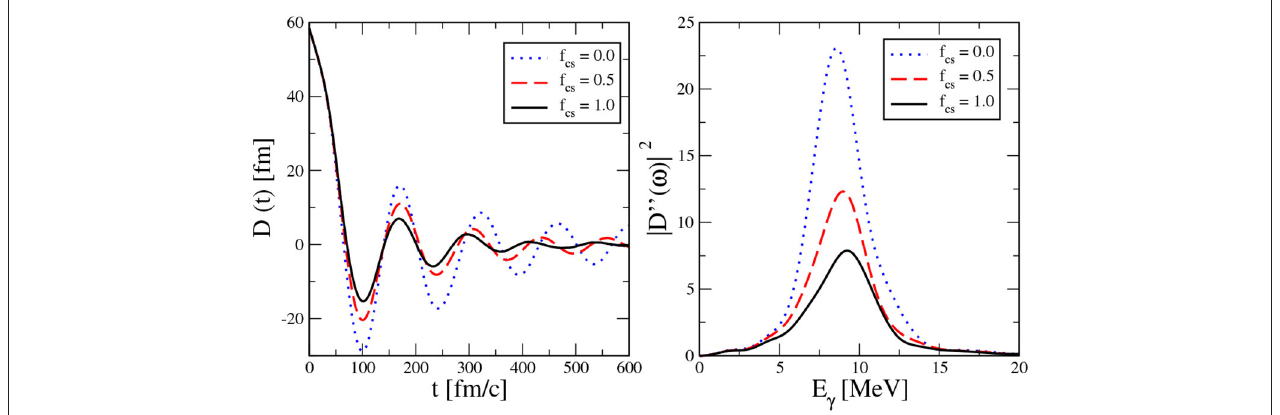
FIGURE 9 | (Color online) Left : The time evolution of DD for the SAMi-J31 EoS at b = 2 fm. Right : the corresponding power spectrum of the dipole acceleration. Results are plotted for different choices of the n-n cross section (see text). Readapted from Zheng et al. [40].